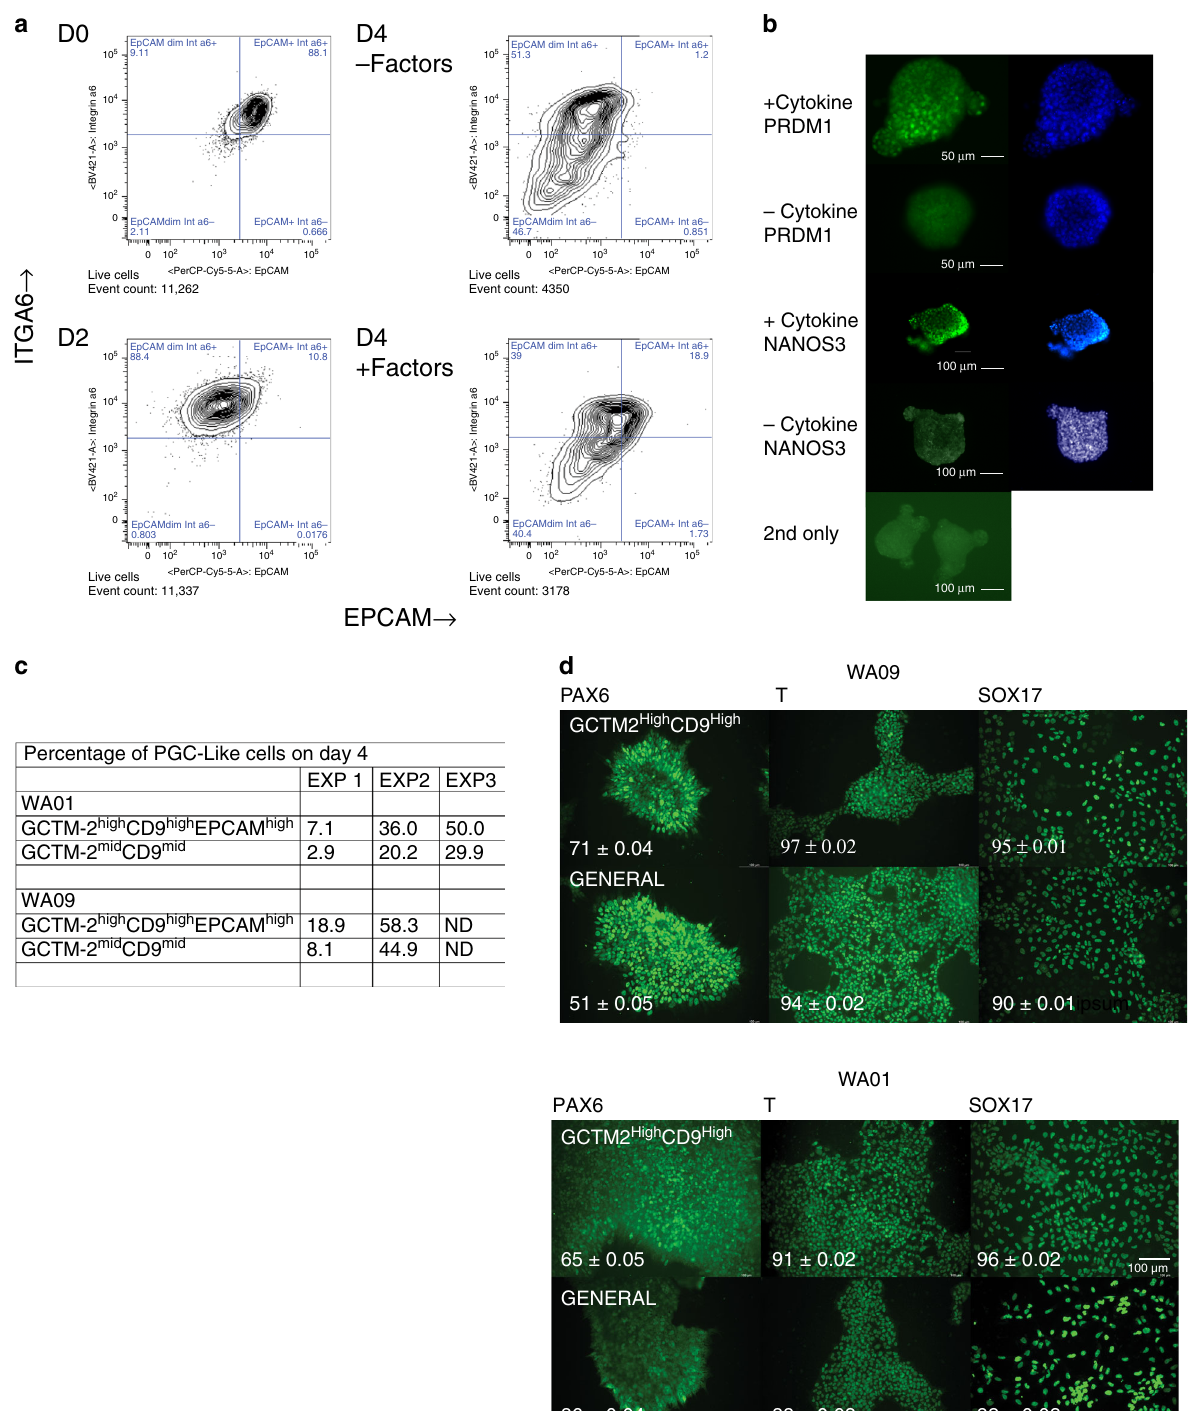
methylation or levels of DNA methylation over CpG islands between the GCTM-2 high CD9 high EPCAM high subpopulation and the general population (Fig. 6a, b). DNA methylation distribu- tions were bimodal (Fig. 6c, d), and there was little evidence of differential methylation at CpG islands across any particular loci in the GCTM-2 high CD9 high EPCAM high subpopulation (Fig. 6e). The extent of DNA methylation at CpG islands in various repeat elements was high and did not vary between the unsorted and GCTM-2 high CD9 high EPCAM high fraction (Fig. 6f). De novo DNA methyltransferases DNMT3A and DNMT3B were both